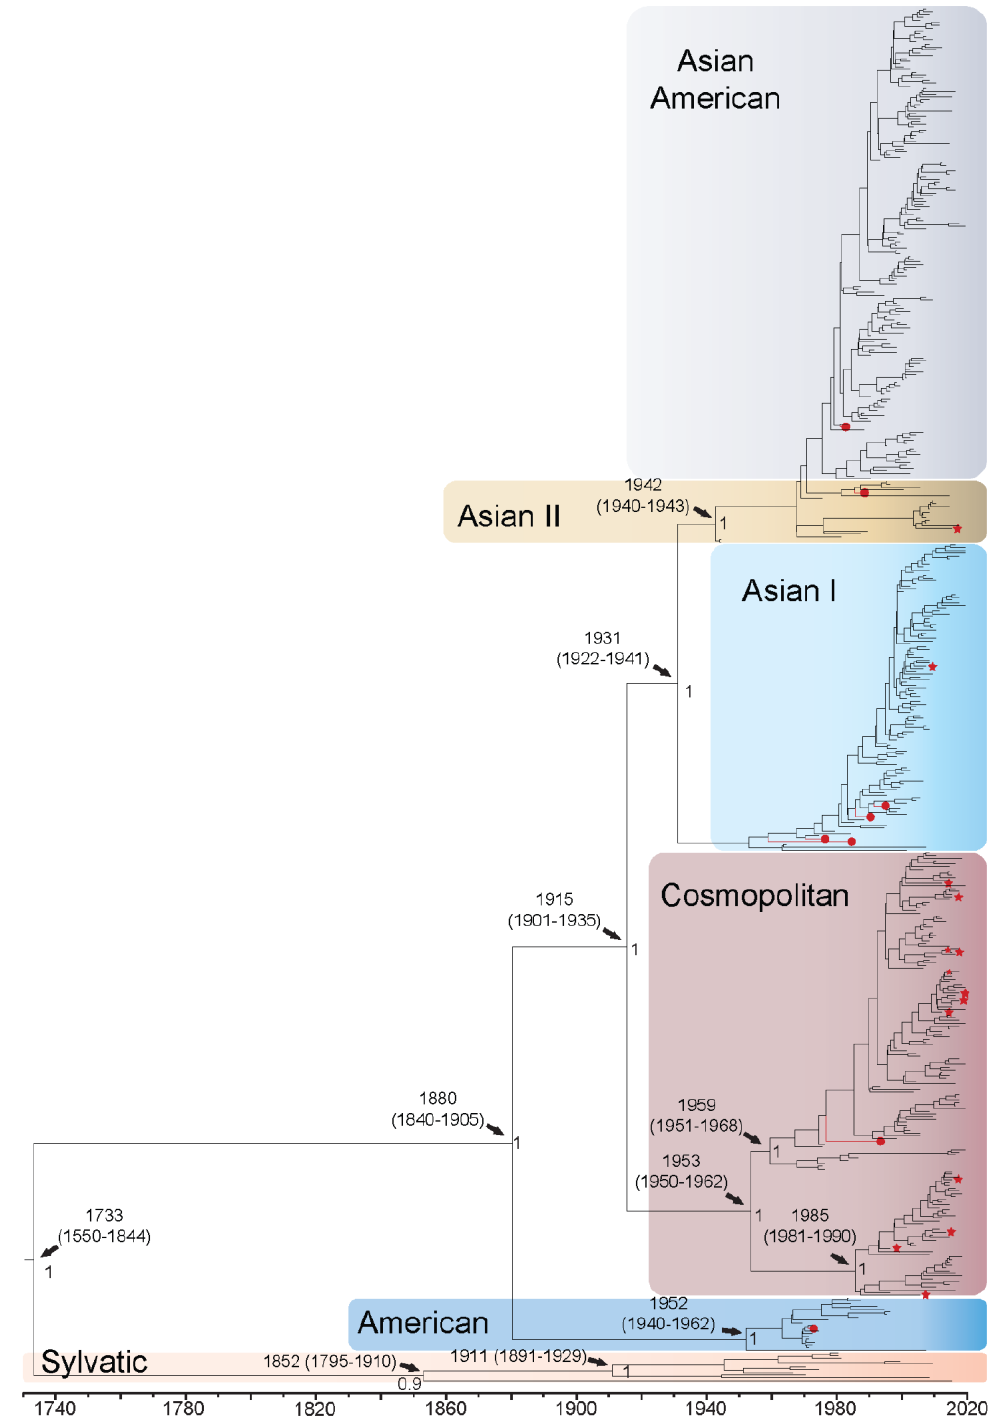
Figure 2. Bayesian phylogenetic tree from analysis of DENV2 whole genome complete coding sequences. Scale axis is representative of calendar years. Posterior node support is indicated for the major branches, with values <0.8 eliminated in most instances for clarity. Red circles indicate newly sequenced isolates from the QUT Arbovirus collection. Branches under positive selection (see Section 3.2.2) are indicated by red stars.